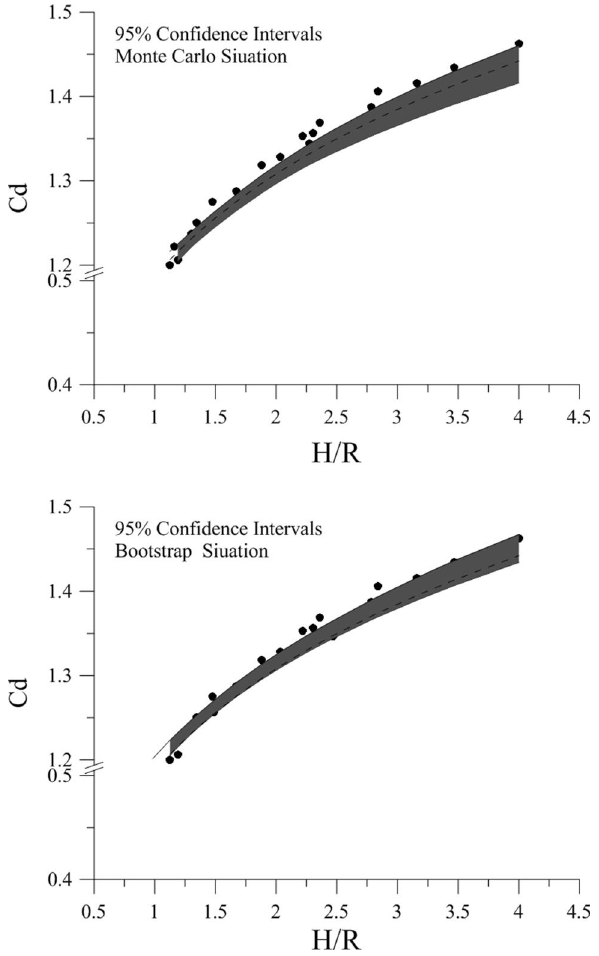
Fig. 5 Ninety-five percent confidence interval for the modeled Cd using MC and